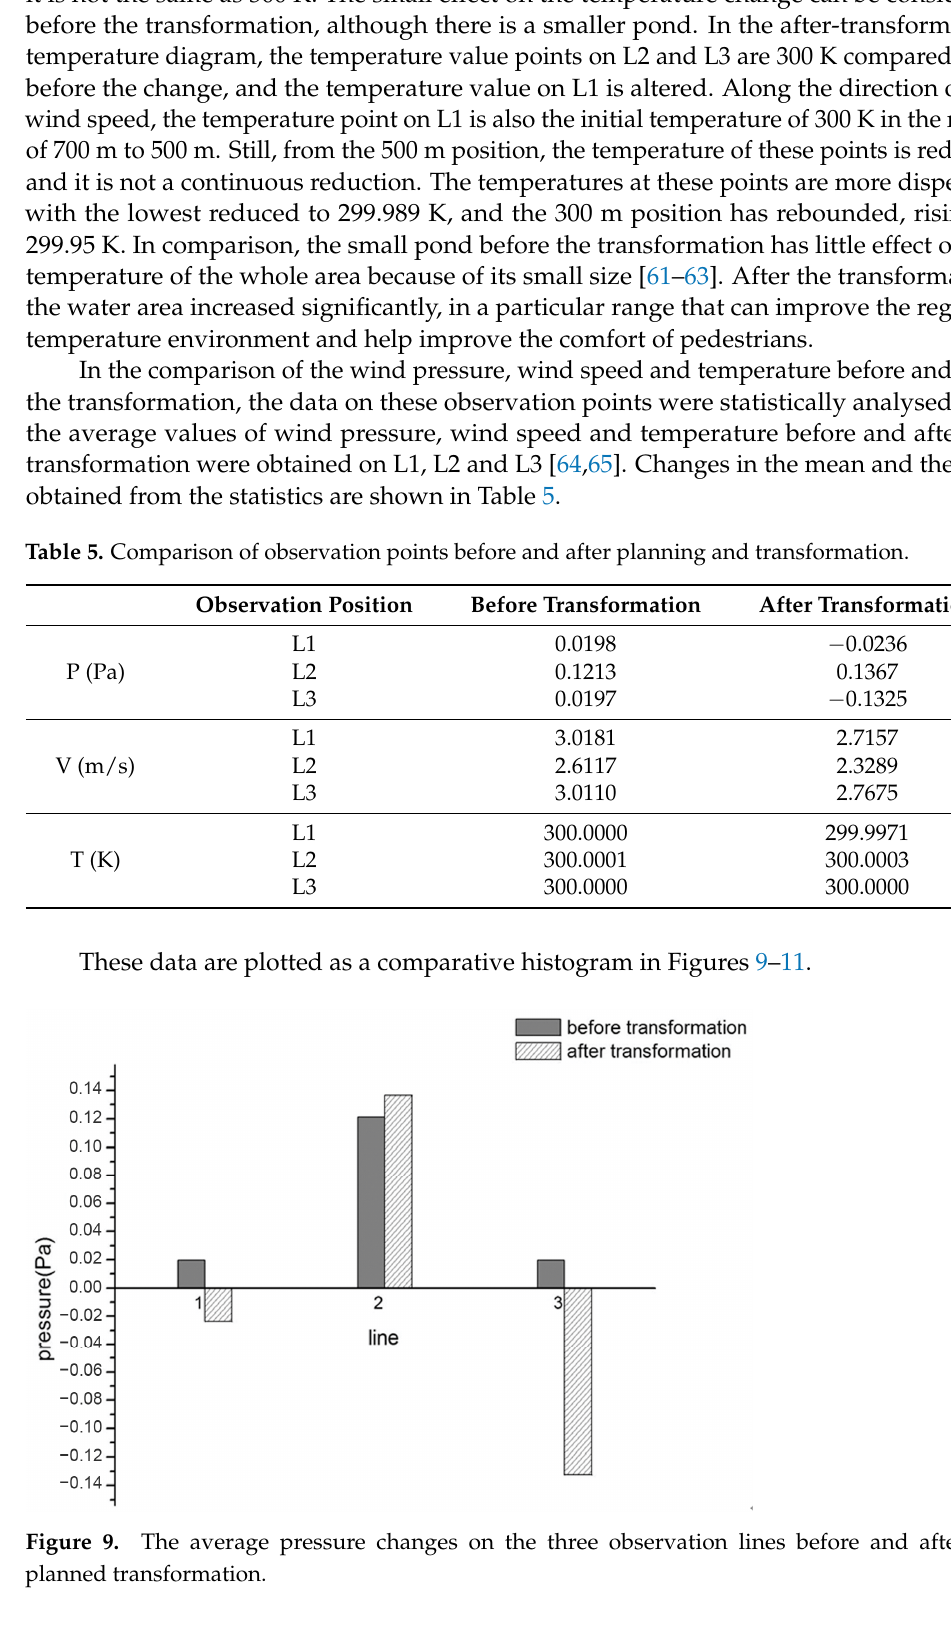
Figure 10. The average wind speed change on the three observation lines before and after the planned transformation.